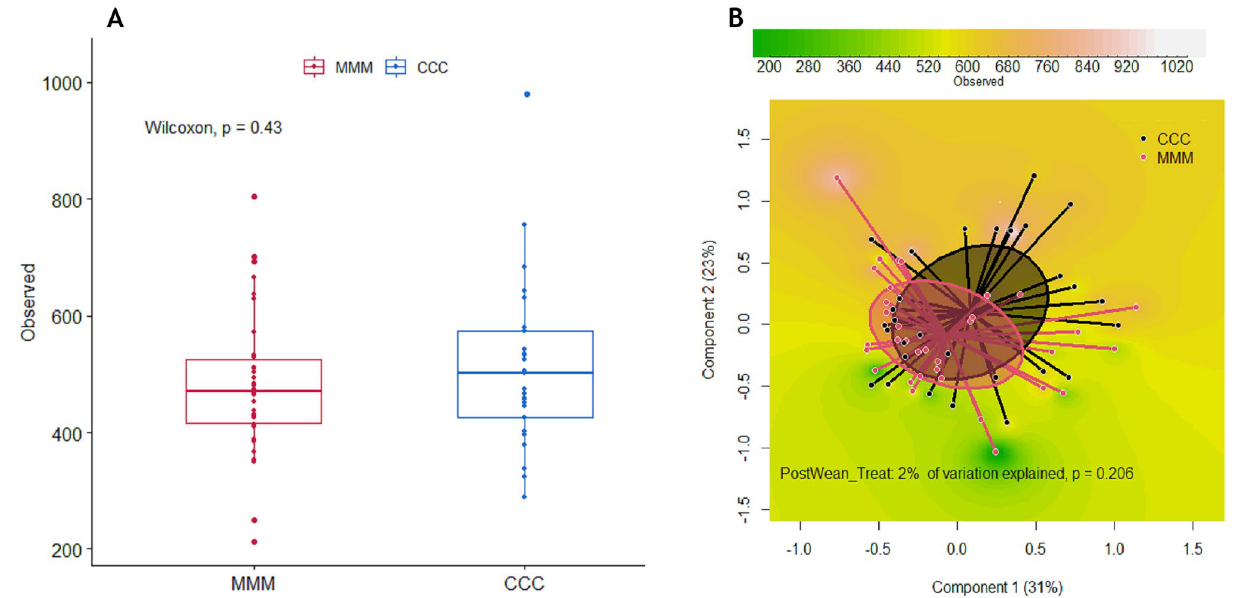
Figure 3. Diversity of gut microbiota of control and MFC piglets. ( A ) Alpha diversity (observed index), and ( B ) Principal coordinates analysis (PCoA)